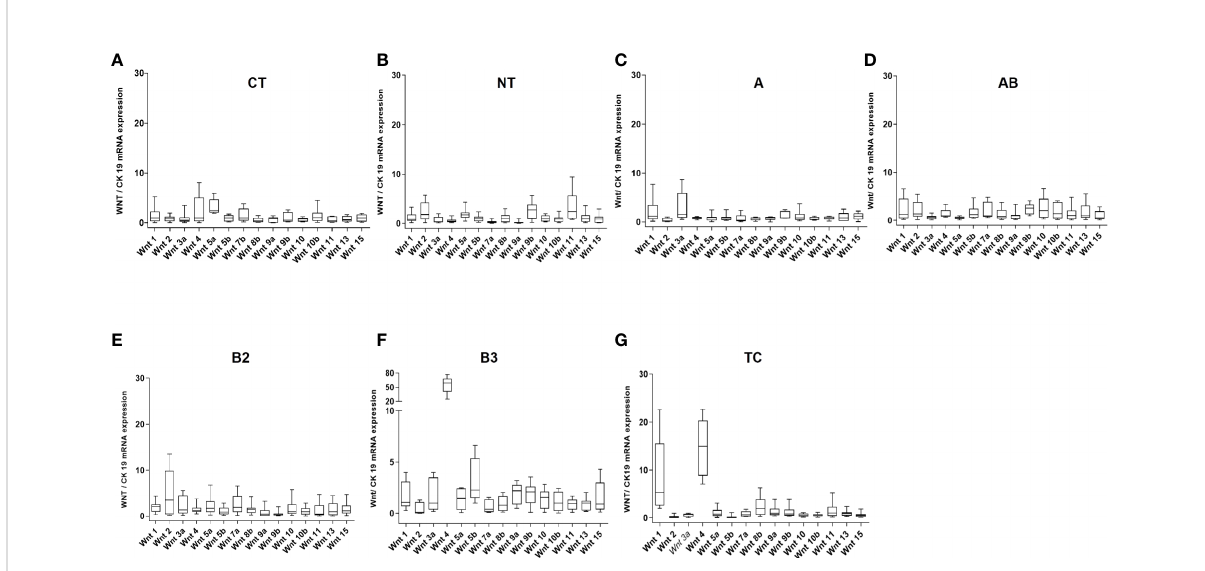
FIGURE 1 mRNA expression levels of 15 WNT ligands in non-neoplastic thymuses and thymic epithelial tumors as determined by Q-PCR. (A) : Childhood thymuses (CT) (n = 6); (B) : Normal thymuses (NT) (n = 15); (C) : Type A thymoma (n = 9); (D) : AB thymoma (n = 21); (E) : B2 thymoma (n = 13); (F) : B3 thymoma (n = 10) and (G) : Thymic carcinoma (TC, n = 10). Cytokeratin 19 was used as a reference to take the variable content of non- neoplastic thymocytes and WNT-producing thymic epithelial cells in the various thymomas into